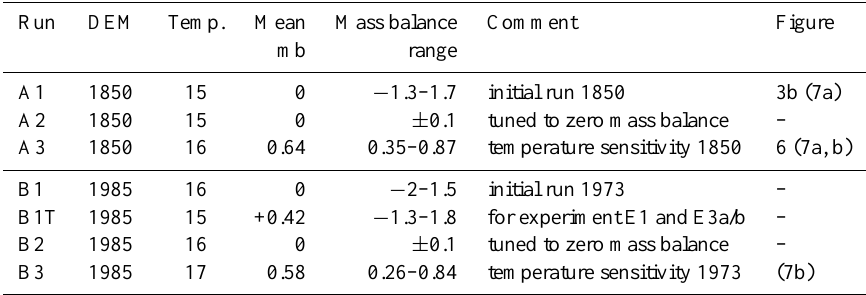
Table 1. Overview of the performed model runs. DEM: used digital elevation model, Temp.: used temperature, Mean mb: mean (area weighted) mass balance for the entire region, Mass balance range: range of individual values, Figures: the results are presented in the indicated figures with the number in brackets refering to the scatter plots. Run Temp.